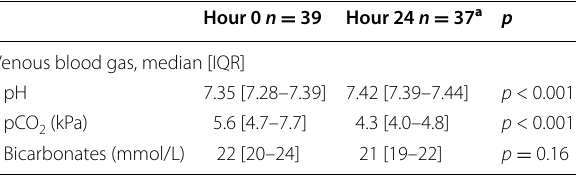
Table 3 Change of blood gas parameters between hour 0 and 24 in children treated with nasal high flow for status asthmaticus